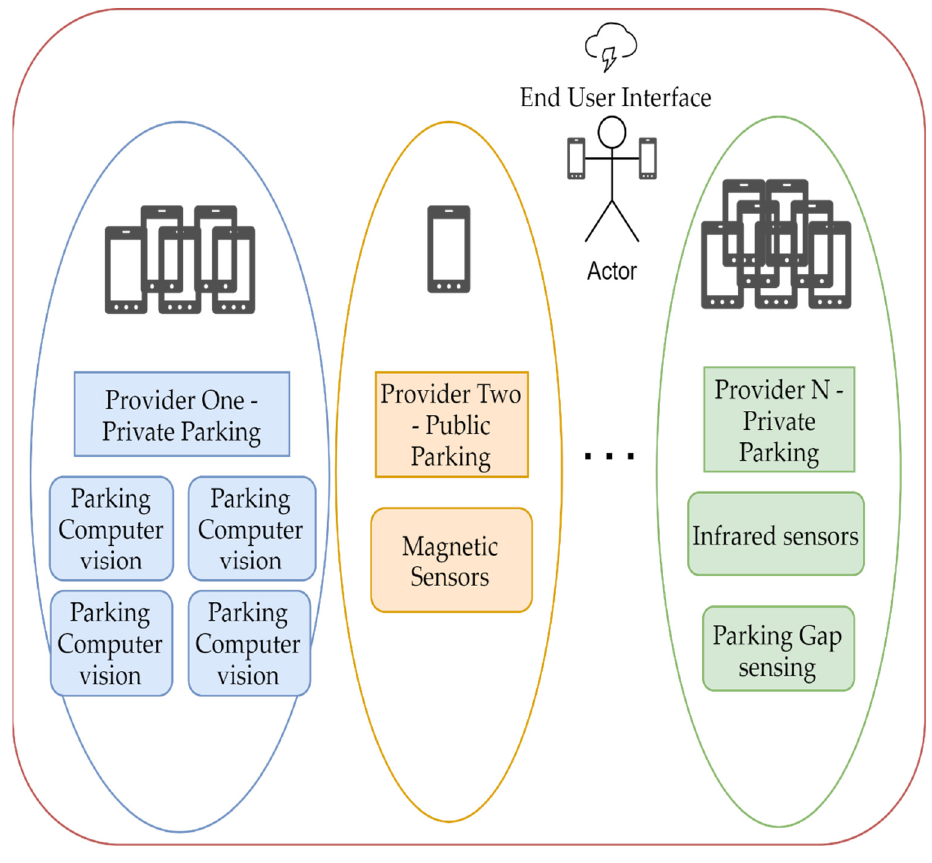
Figure 2. The current model of smart parking implementations in a certain geographical area, covered by three independent parking providers.